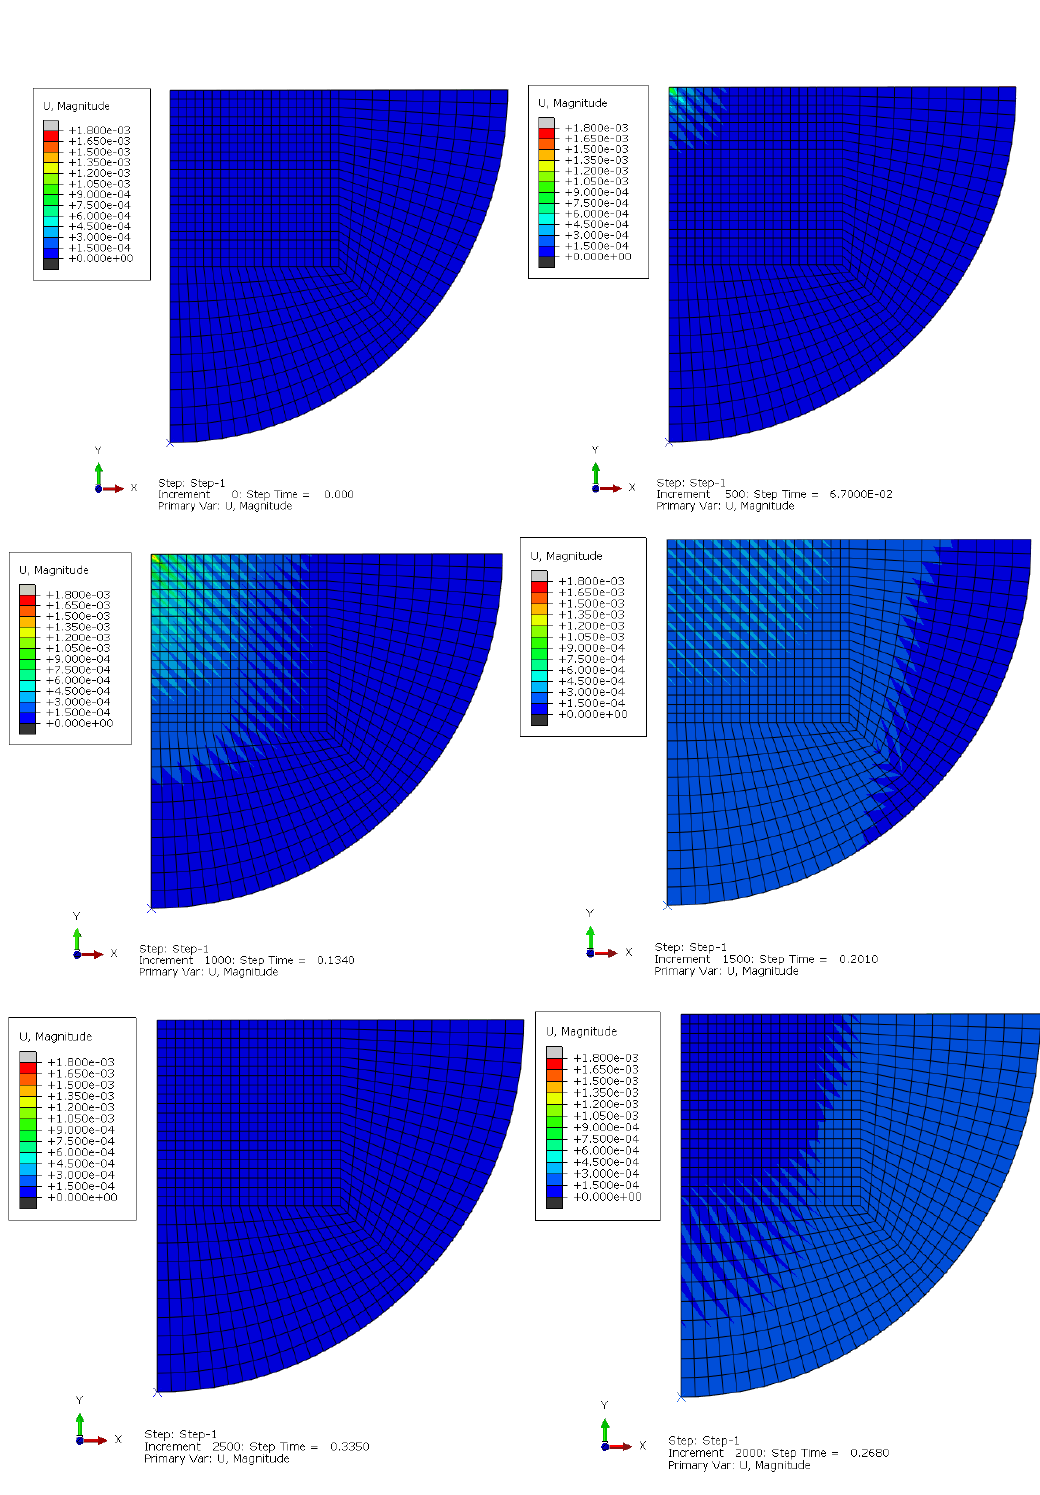
Figure 11. Snapshots of displacement contours showing the wave